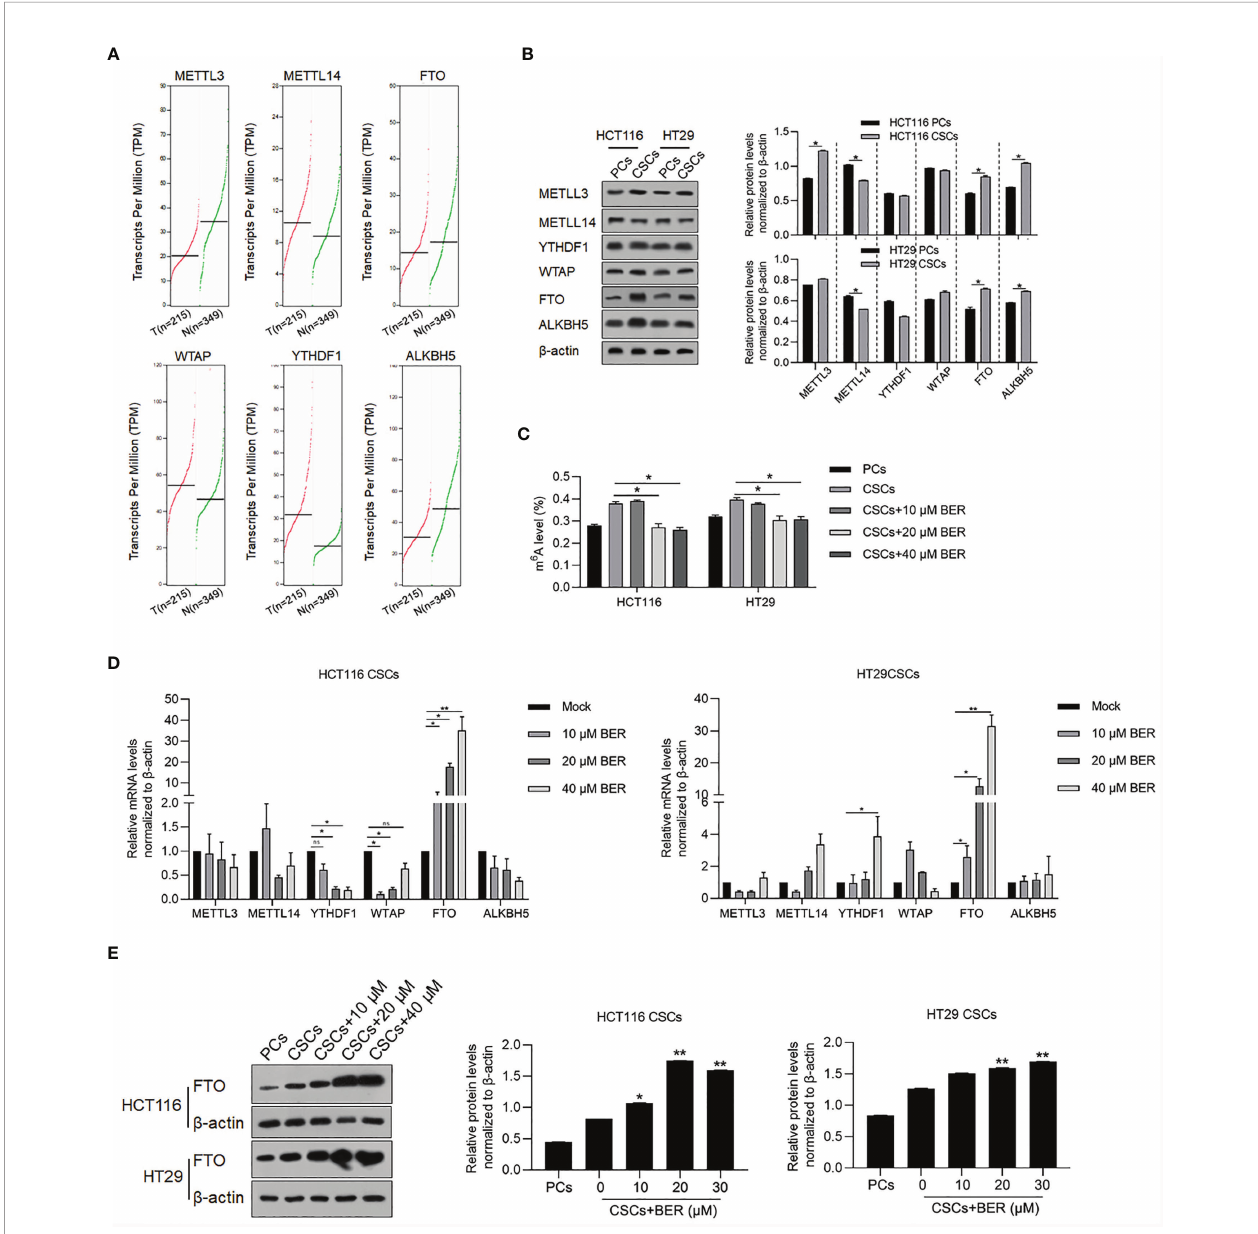
FIGURE 2 | Berberine decreased m6A modi fi cation of total RNAs in CSCs. (A) METLL3, METLL14, FTO, WTAP, YTHDF1, and ALKBH5 mRNAs were analyzed in colorectal cancer samples compared with normal samples. (B) Protein levels of METLL3, METLL14, FTO, WTAP, YTHDF1, and ALKBH5 in CSCs and parental cells were measured by performing western blot. *p < 0.05, vs. PCs. (C) Total m 6 A levels in CSCs with or without Berberine treatment by EpiQuik m6A RNA Methylation Quanti fi cation Kit. RT-qPCR testing the mRNA levels (D) and Western blot examine the protein levels (E) of m 6 A regulating proteins. *p < 0.05, **p < 0.01, vs. 0 m M